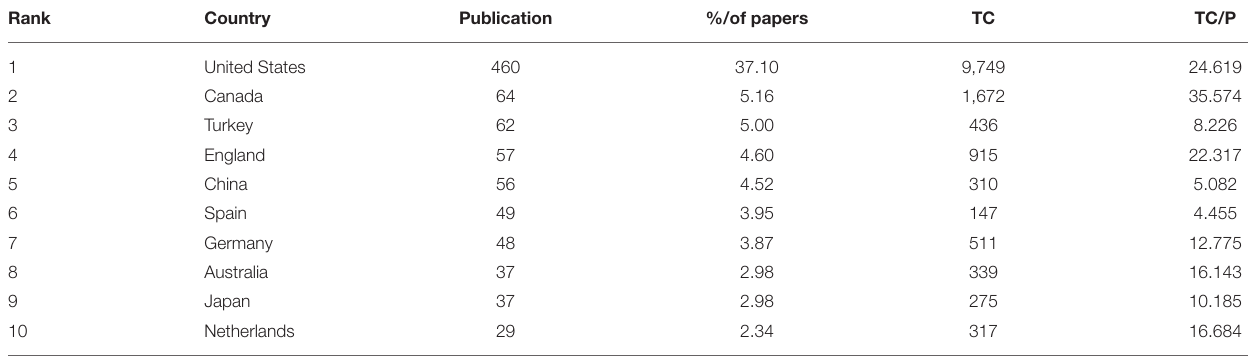
TABLE 2 | Top 10 countries based on publications.